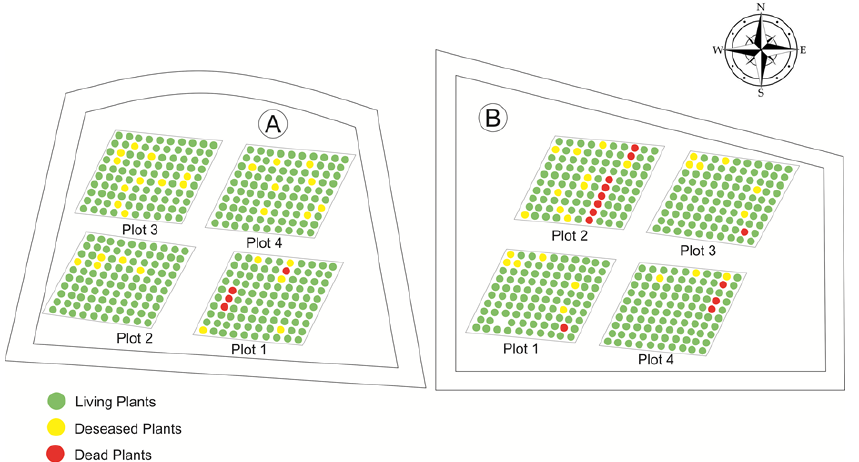
Figure 3. The layout of the sampling plots of the planting (100 planting for each plot with a total of 800 planting); ( A ). Planting using seedlings, ( B ). Planting using propagules. The green circle represent health mangroves, the yellow are pest-affected mangroves, while the red were indicated mortality.